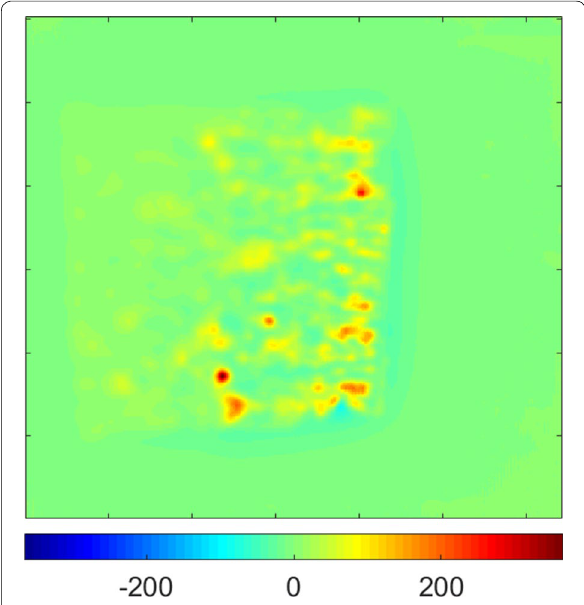
Fig. 8 Ferromanganese crust SIRM B z field map (the positive direction is out of page) obtained by scanning SQUID in nT at a 100 µ m resolution with a sensor-to-sample distance of 319 µ m. The field of view is 30.1 mm × 32.1